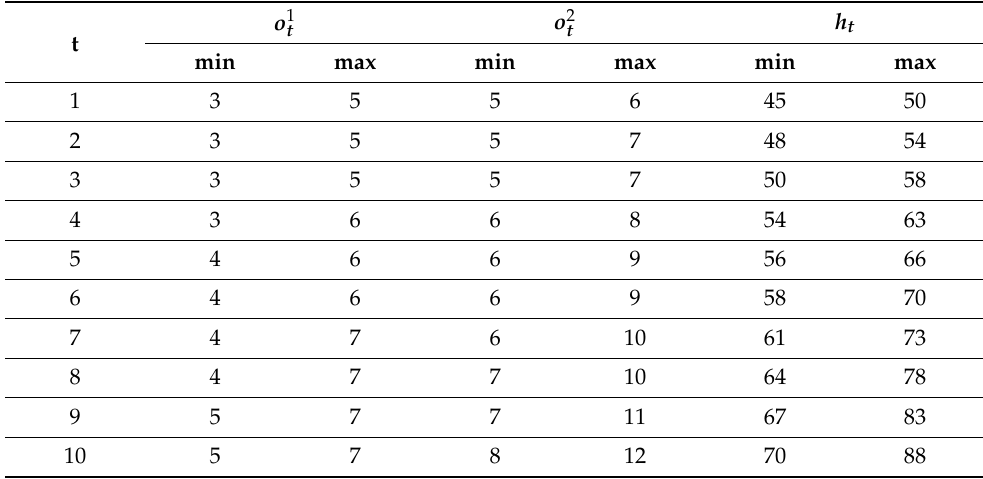
Table A2. The source information for the model of investment project assessment in the system of indicators of risk-efficiency (forecasting